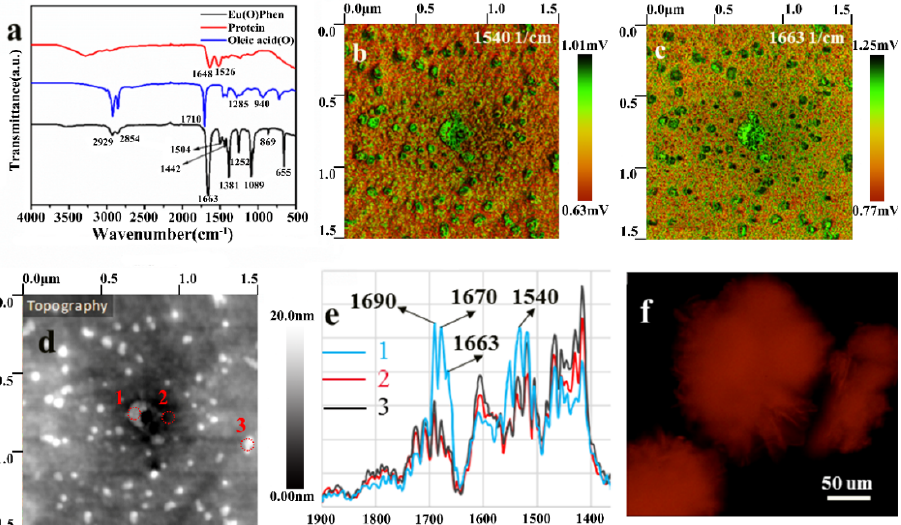
Figure 4. The concentration of oleic acid used during nanolabel synthesis was 0.05 mol L − 1 in FTIR spectra and PiFM images. ( a ) FTIR spectra of protein, oleic acid, and OEu 3+ Phen complexes; PiFM images taken with laser tuned to ( b ) 1540 cm − 1 for protein and ( c ) 1663 cm − 1 for OEu 3+ Phen complexes in the sample; ( d ) the detection points of the sample, overlaid on a topographical map; ( e ) PiFM infrared spectra for the detection points; ( f ) the fluorescence microscopy image of the sample.